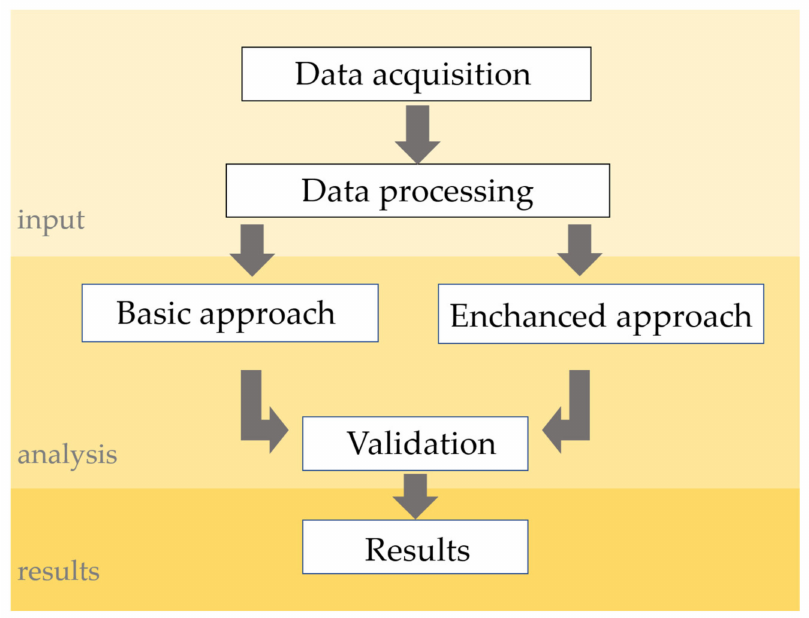
Figure 2. Research